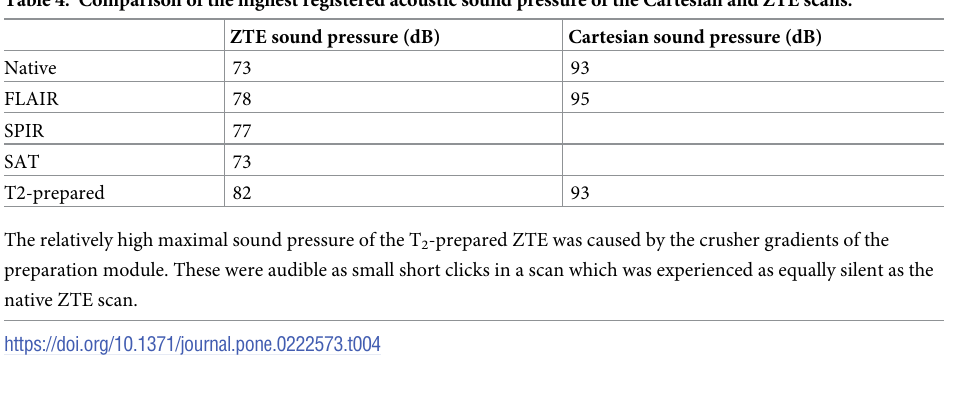
Table 4. Comparison of the highest registered acoustic sound pressure of the Cartesian and ZTE